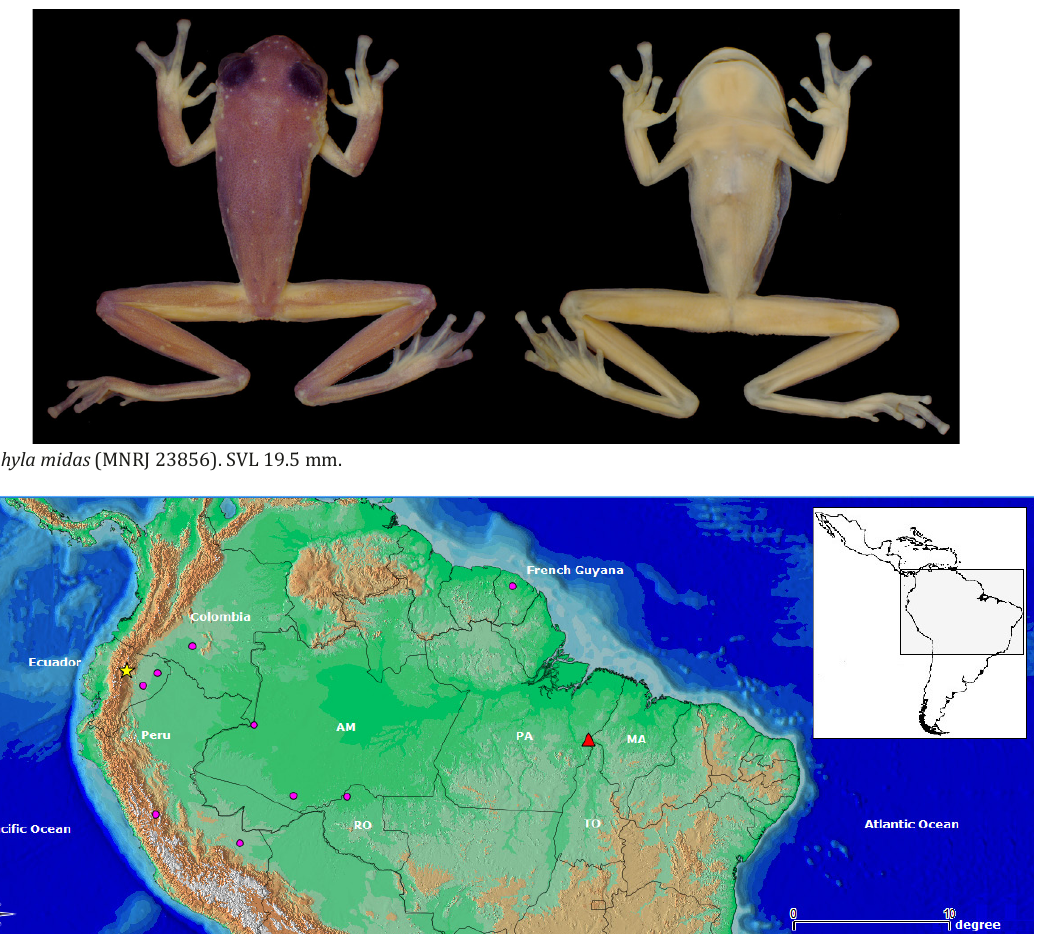
Teratohyla midas Figure 2. et al. Distribution map of . Yellow star: type-locality (Santa Cecília, Província de Napo, Ecuador); Pink circle: literature records - Rodriguez 2004 (Panguana, Departament of Huánuco and Pakitza Department of Madre de Dios, Peru) Cisneros-Heredia and McDiarmid 2005 (Province of Orellana, Napo, and Pastaza, Ecuador); Lynch 2005 (Letícia, Department of Amazonas, Colombia); Kok and Castroviejo-Fisher 2008 (Crique et al. Grand Leblond, French Guyana); França and Venâncio 2010 (Boca do Acre, estado do Amazonas, Brazil); Melo-Sampaio and Oliveira 2013 (Porto Velho, Rondônia, Brazil); Malambo 2013 (Belén de los Andaquies and Florencia Department of Caquetá, Colombia); red triangle: new record for São Pedro da Água Branca, Maranhão, Brazil.